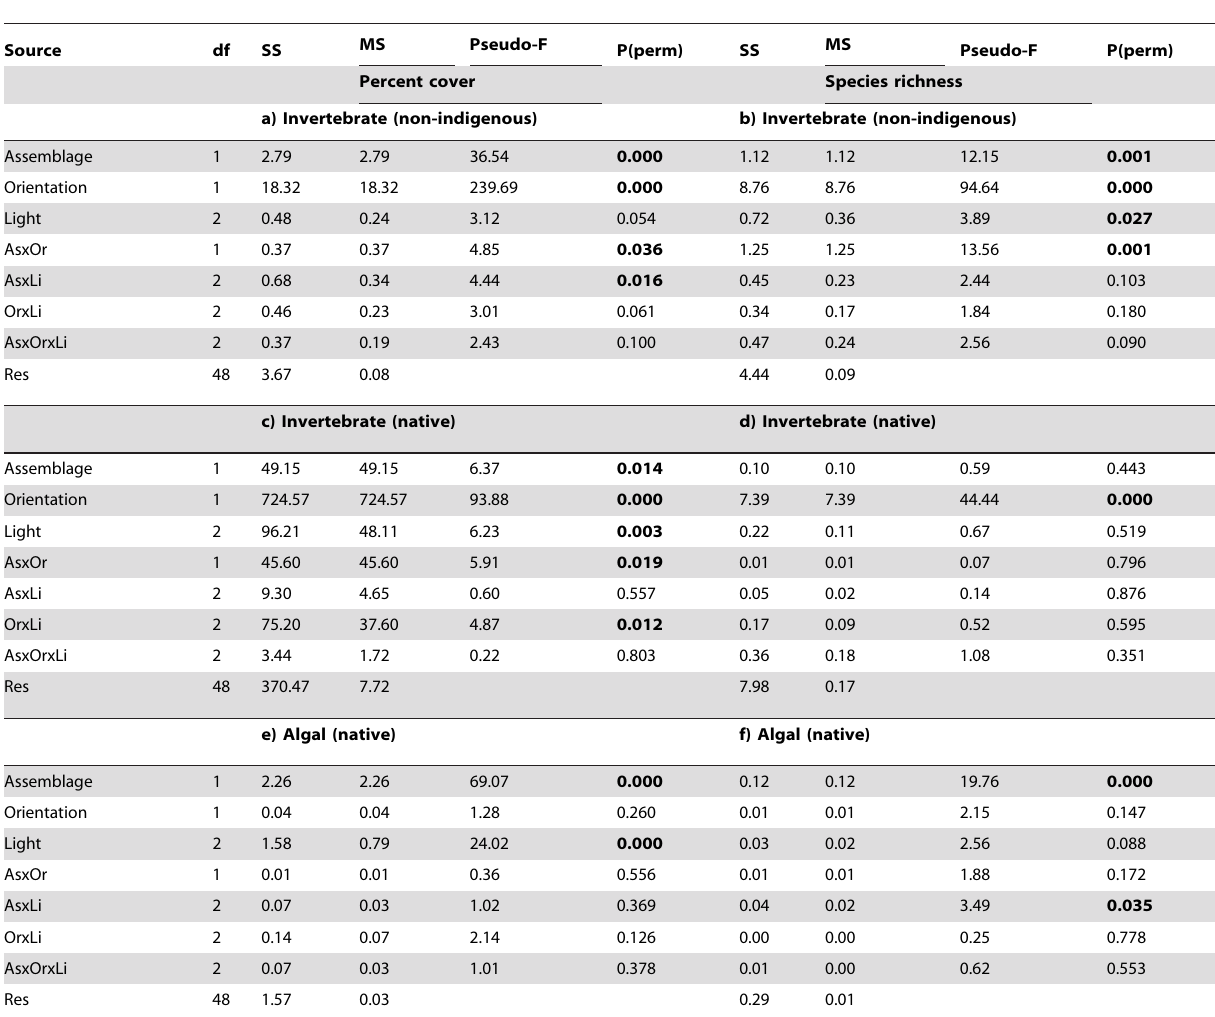
Table 5. PERMANOVA results comparing the non-indigenous and native species percent cover and richness sampled from experimental ‘‘reef’’ (sandstone